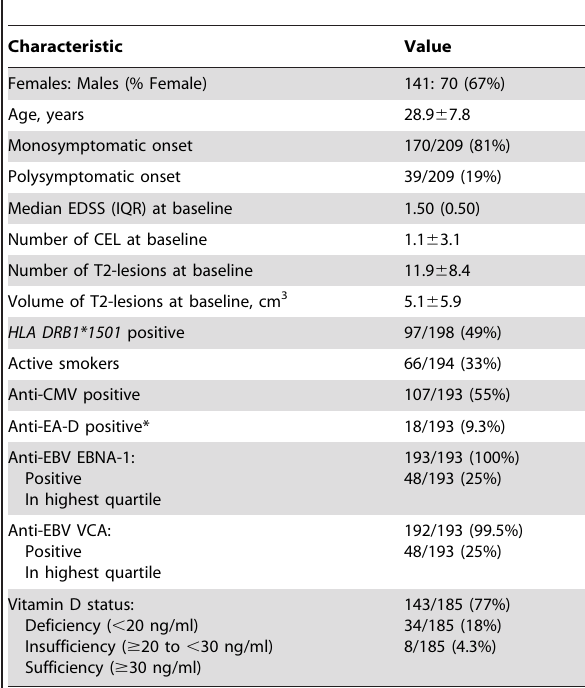
Table 1. Demographic, clinical and other characteristics